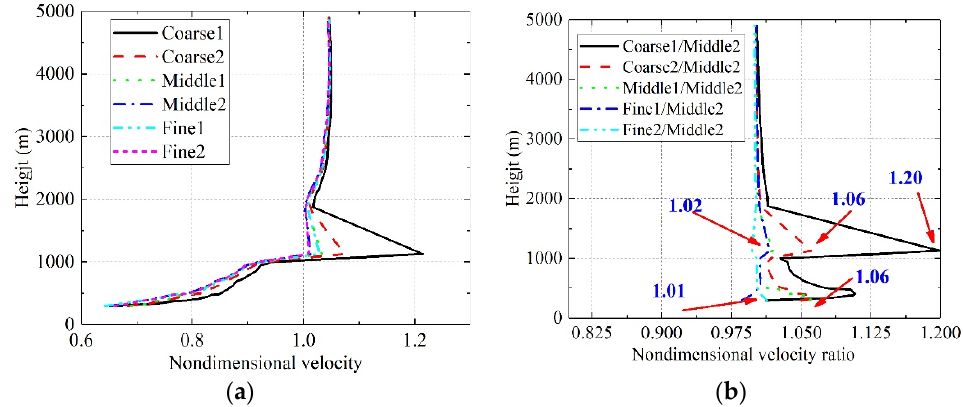
Figure 3. Grid independence verification. ( a ) Nondimensional velocity profile. ( b ) Nondimensional velocity ratio.